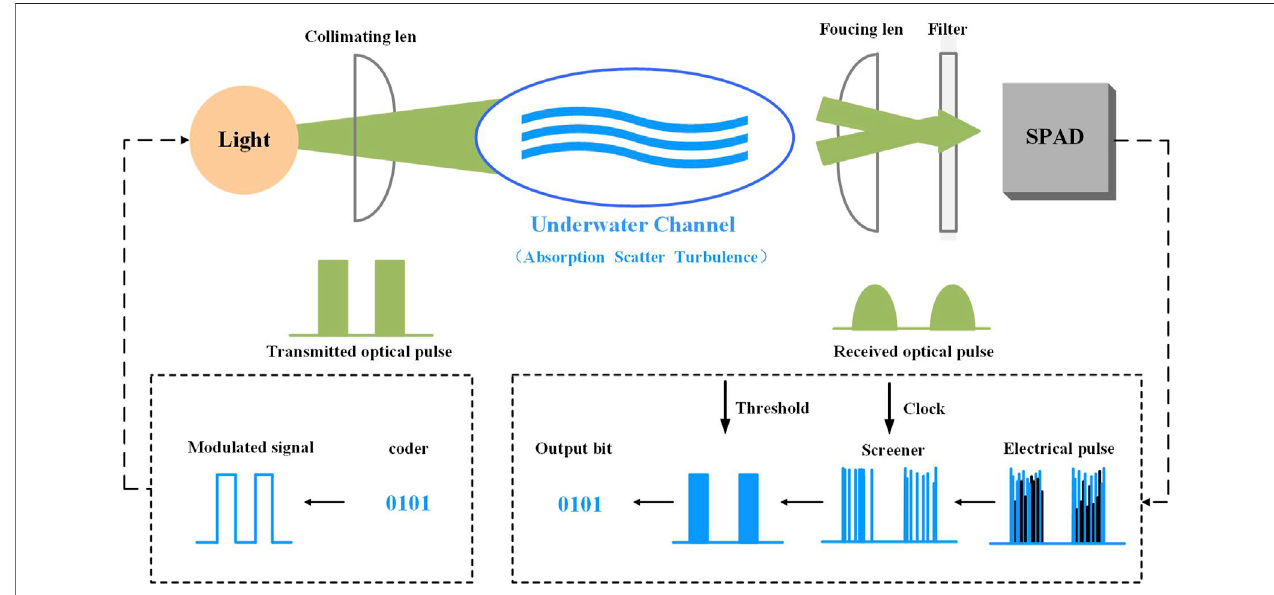
FIGURE 1 | The conceptual diagram of underwater photon-counting communication (UPCC) system. The system consists of two parts: intensity modulation and directdetectionphoton-countingreceiver.Theinformationbitsareencodedandmodulatedintoanopticalsignal;theopticalsignalistransmittedthroughtheunderwater channel, and only a few photons are received. The photons are then received by a single-photon avalanche diode (SPAD) and converted into electrical pulses that are synchronized, counted, and demodulated to recover the original bits.